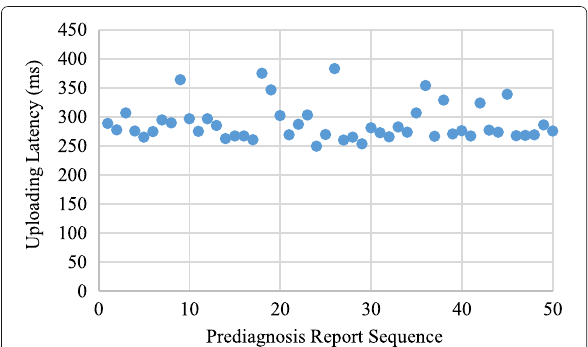
Fig. 8 The 50 prediagnosis reports’ uploading latencies under the serial FIFS transmission mechanism